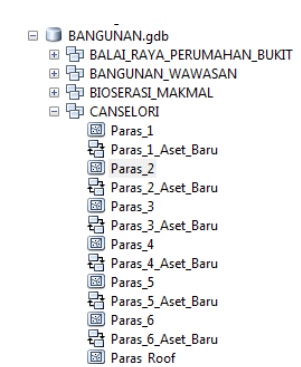
Figure 15. UKM FM building geodatabase, level floor/room and asset